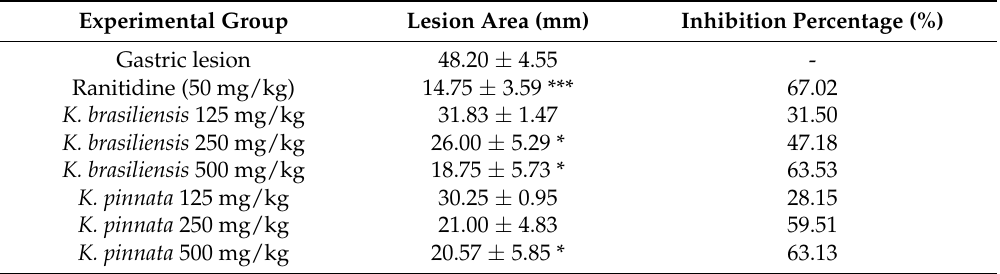
Table 4. Effect of pre-treatment with Kalanchoe brasiliensis and Kalanchoe pinnata leaf juice (125, 250 and 500 mg/kg) in the lesion area and inhibition percentage in the indomethacin-induced